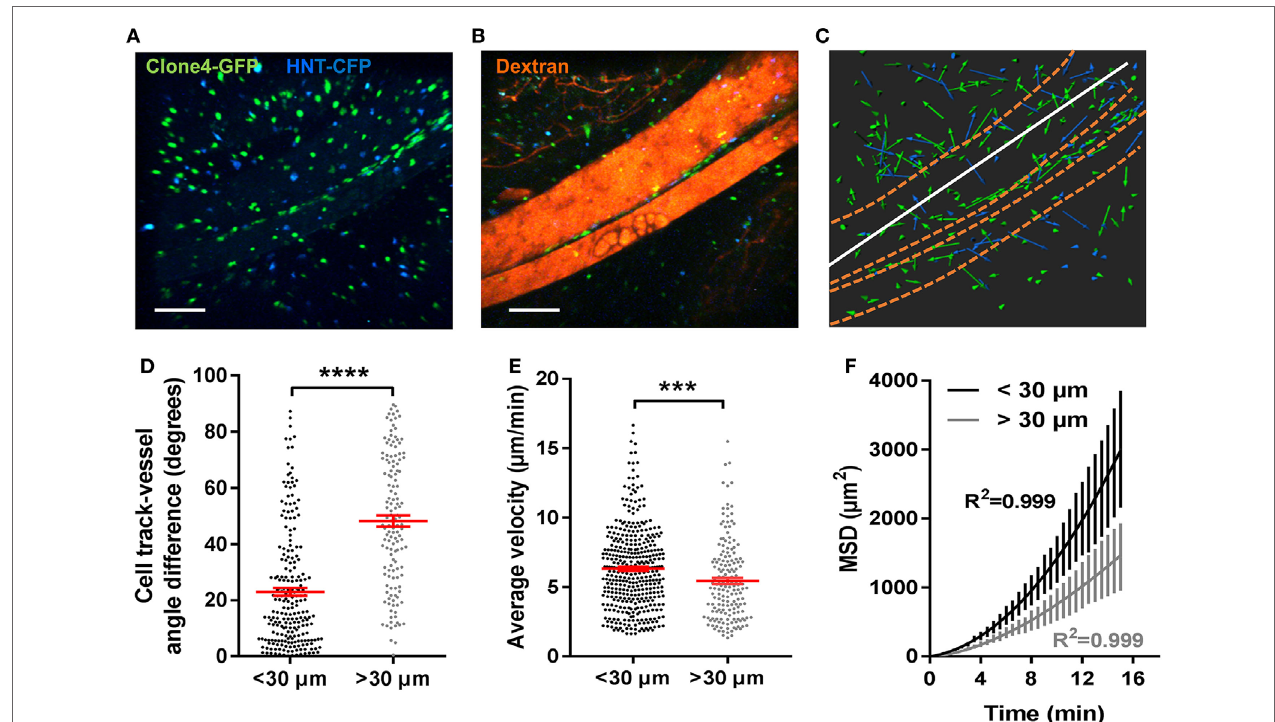
FigUre 3 | Blood vessels in the exocrine tissue contribute to effector T cells-directed mode of motility. Irradiated InsHA-mCherry mice adoptively transferred with Clone 4-GFP CD8 + and HNT-CFP CD4 + T cells were subjected to intra-vital microscopy on day 8. (a) Still images from a movie at day 8 post transfer (scale: 100- and 300-µm Z -projections) (B) Still image from the movie in (A) post-injection of 150-kDa dextran-rhodamine (scale: 100- and 300-µm Z -projection). (c) XY projections of track displacement vectors of T cells in the movie depicted in (a) . Blue and green tracks